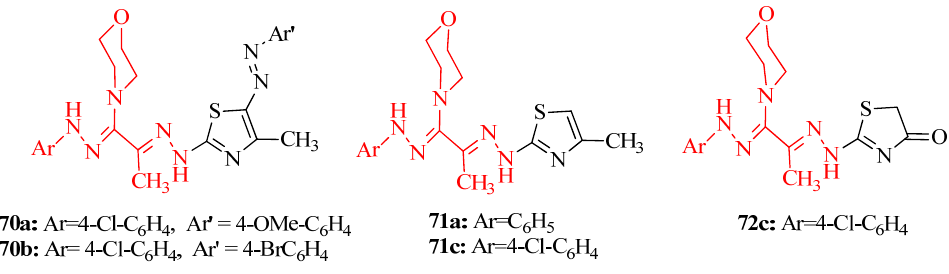
Figure 27. Structures of